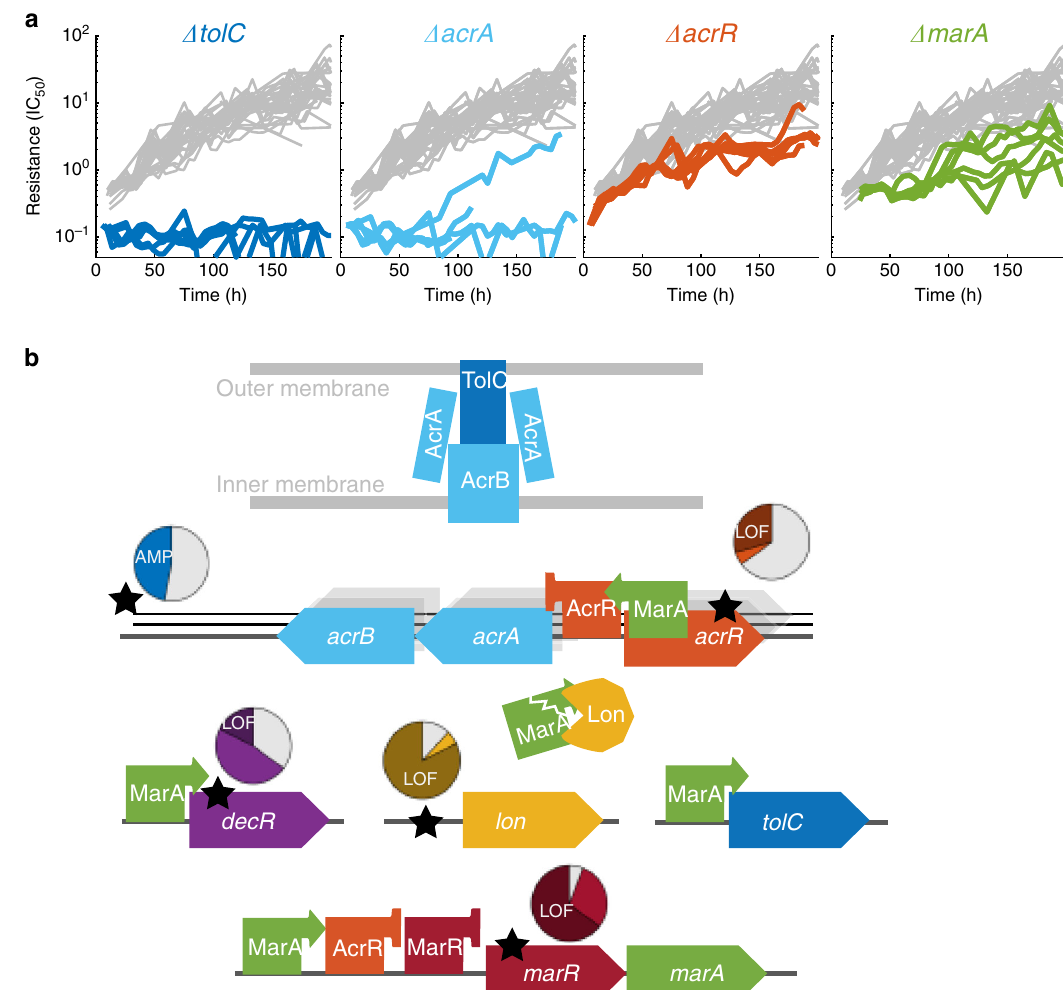
Fig. 3 Perturbing multidrug ef fl ux pumps can drastically reduce the evolvability of tetracycline resistance. a Resistance (IC 50 ) over time for evolution experiments started from the Δ tolC, Δ acrA, Δ acrR, Δ marA strains. All these genes are directly involved in the most common path to resistance shown in ( b ). Gray lines show resistance over time for 22 replicates of the reference strain ( Δ lacA ) for comparison. Data are from experiments M2 and M3 (Methods, Supplementary Table 2, Source data). b Schematic of AcrAB-TolC multidrug ef fl ux pump in the membrane and genes that regulate it. Big arrows are genes, squares with pointing or blunt arrows are transcriptional activators or repressors, respectively, and the Pacman shape is a protease (Lon). The fi ve most common mutation loci (Supplementary Fig. 2, Supplementary Data 1) are marked by stars; ampli fi cation of a genome region is shown as stacked black lines representing copies of DNA. Each mutation locus has a pie chart near it where colored segments represent the proportion of evolved populations started from the reference strain ( Δ lacA ) which gained a mutation in that locus during the experiment. Slices of a darker shade of the gene color represent the proportion of samples with predicted loss-of-function mutations in that